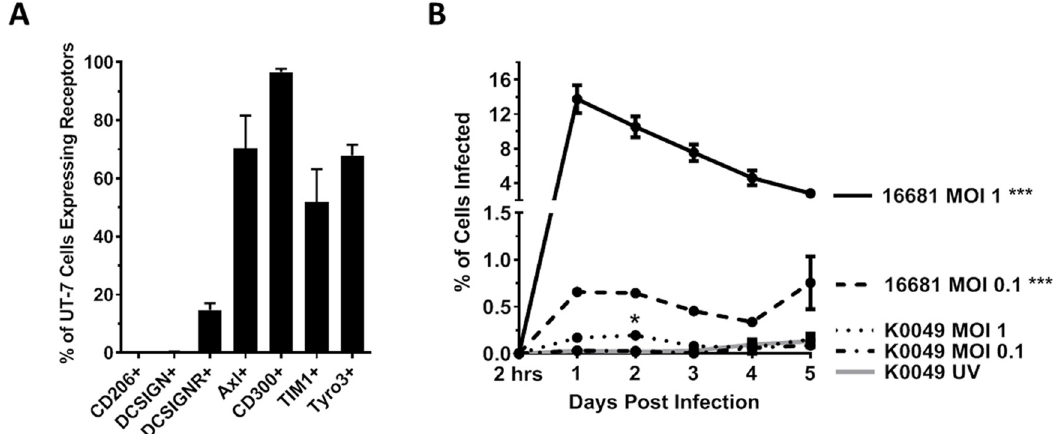
Fig 1. Dengue virus infects UT-7 Cells. (A) Using flow cytometry, UT-7 expression of putative DENV receptors were interrogated. Data from three independent experiments are represented as the mean percentage of the UT-7 cell population that was positive for a given receptor. Error bars are 1 standard error of the mean (SEM). (B) UT-7 cells infected with DENV-2 strains K0049 and 16681 were fixed, permeabilized, and incubated with antibody against DENV envelope protein. Samples were interrogated via flow cytometry, and data from three independent experiments are represented as the percentage of the UT-7 cell population that was infected (positive for DENV envelope). Error bars are 1 SEM. Statistical significance was determined using a two-way ANOVA and multiple comparisons t-test (with Holm-Sidak correction). Statistical significance next to the virus strain name indicate that that infection was significantly different from the UV-inactivated control as assessed by two-way ANOVA. Significance at a specific timepoint indicates that the condition at that timepoint was significantly different from the UV-inactivated control via t-test but that the overall infection was not significantly different via ANOVA. � p < 0.05; �� p < 0.01; ��� p < 0.005; ���� p < 0.001.